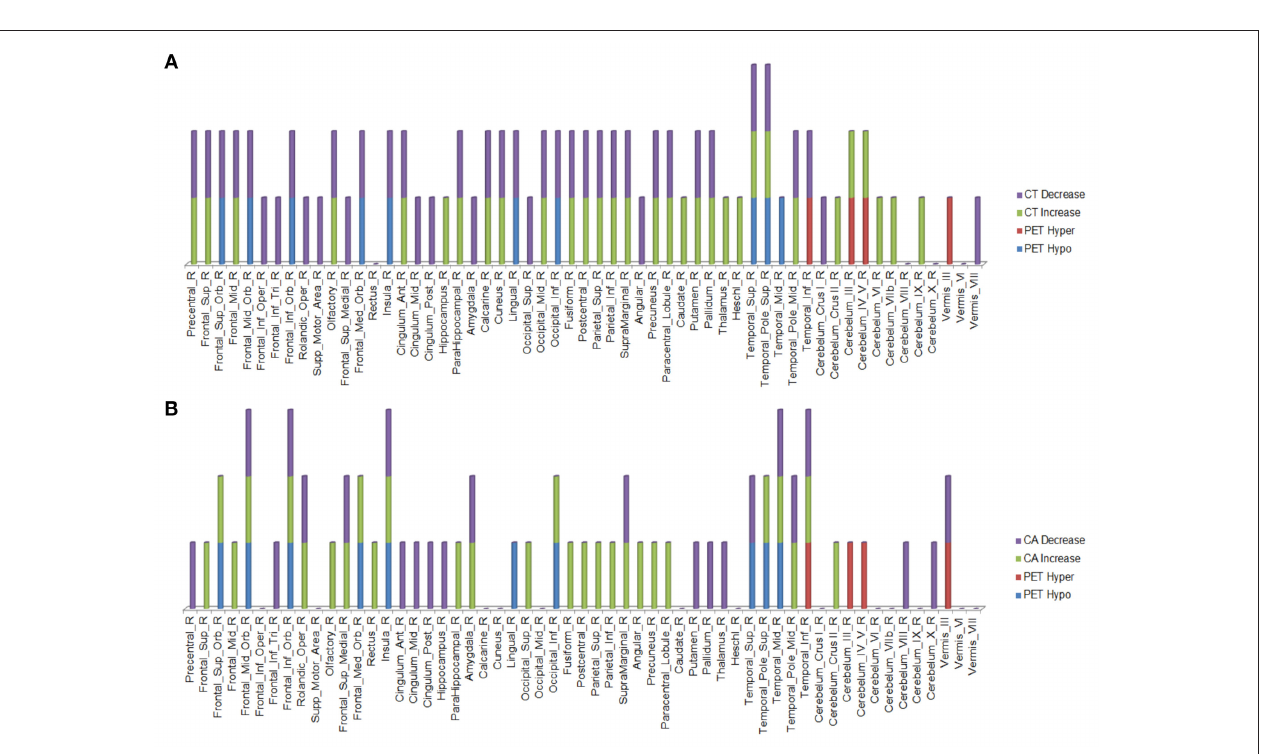
FIGURE 4 | Right hemisphere brain regions with changes in cortical thickness (CT) (A) and cortical area (CA) (B) relative to alterations in 18 F-FDG PET